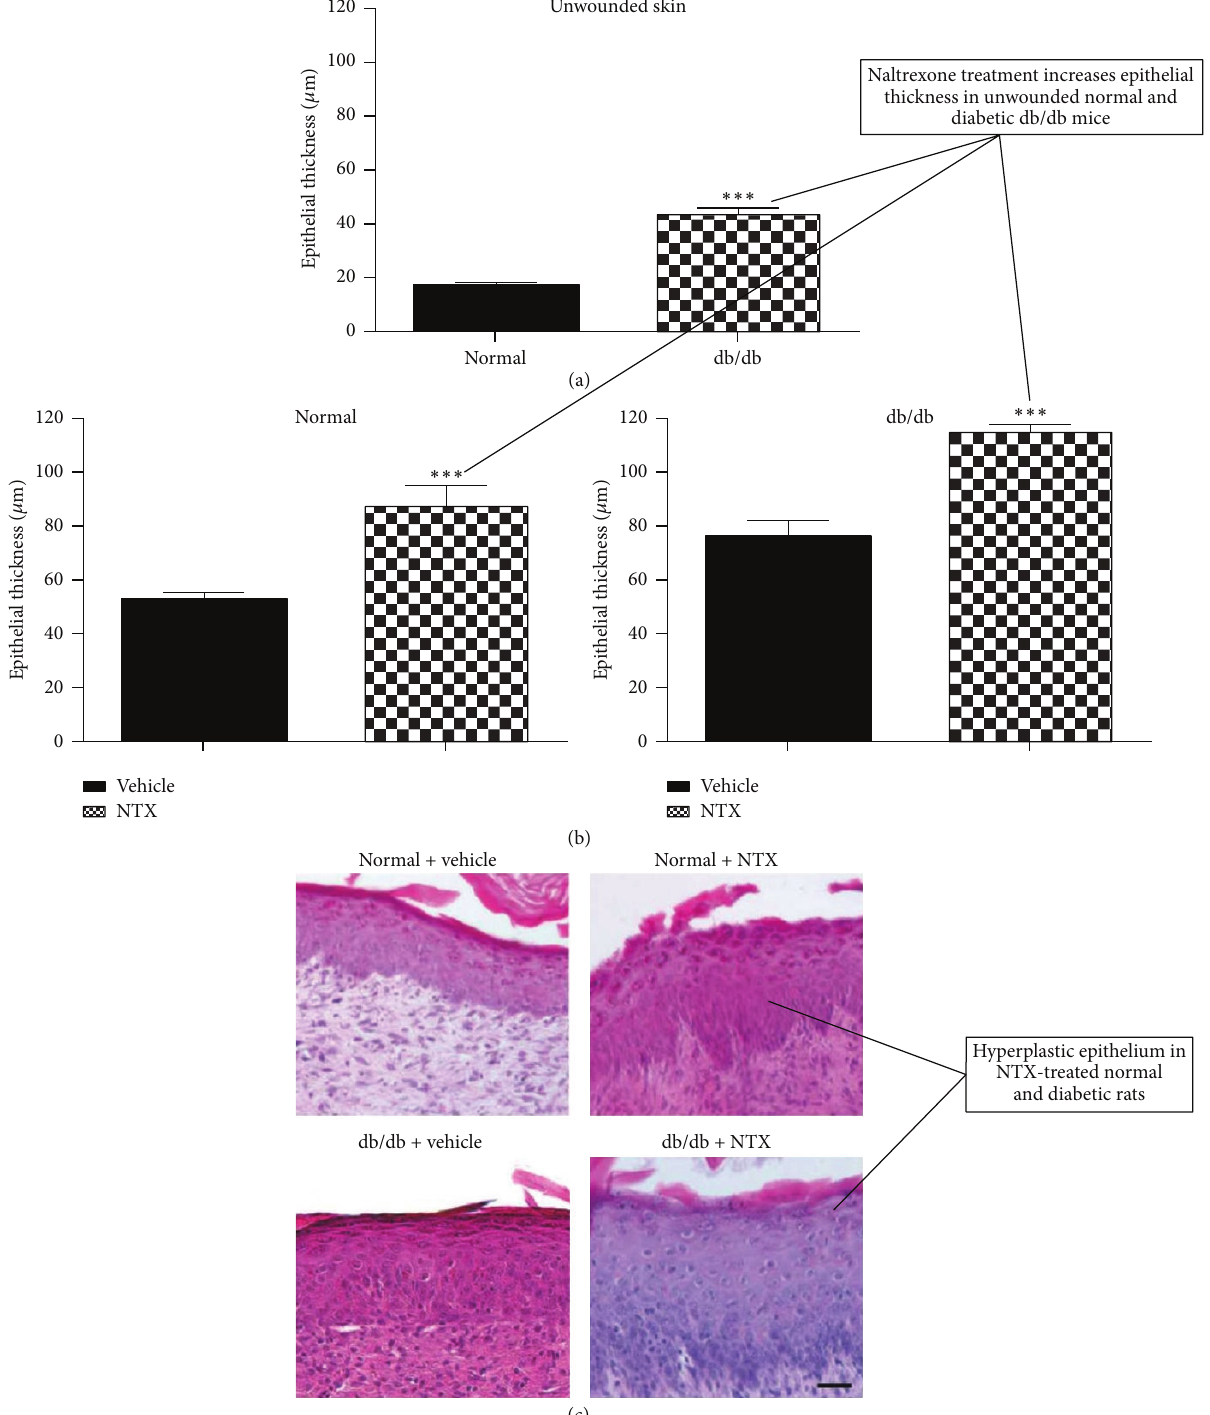
Figure 22: Histograms and photomicrographs illustrate the impact of 14 days of treatment with topical application three times daily of NTX or saline dissolved in Neutrogena moisturizing cream on the epithelialization of cutaneous wounds in normal and diabetic (db/db) mice. (a) The epithelium is hyperplastic in the NTX-treated normal and DB mice as illustrated in the histogram of epithelial thickness in normal and db/db unwounded skin. Values represent means ± SEM. Significantly different from normal values at ∗∗∗ 𝑃 < 0.001 . (b) Histograms of epithelial thickness over the underlying connective tissue in the wound bed in normal and db/db wounded skin treated with NTX or saline dissolved in moisturizing cream (vehicle). Values represent means ± SEM. Data from NTX-treated wounds were compared with vehicle- treated wounds for normal or db/db mice. Significantly different from vehicle-treated specimens at ∗∗∗ 𝑃 < 0.001 . (c) Photomicrographs of epithelium stained with hematoxylin and eosin permit comparison of the epithelial thickness among normal, diabetic NTX-treated, and control epithelium; bar = 25 𝜇 m (derived from